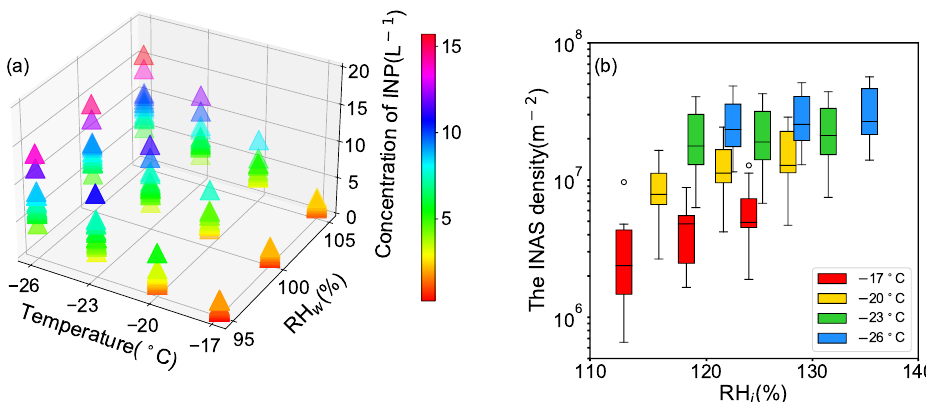
Figure 3. The INP concentrations ( a ) and ice nucleation active surface site density ( b ) under different activation conditions. The boxes represent the interquartile range. The upper and lower edges of the vertical lines represent the maximum and minimum values respectively. Circles represent